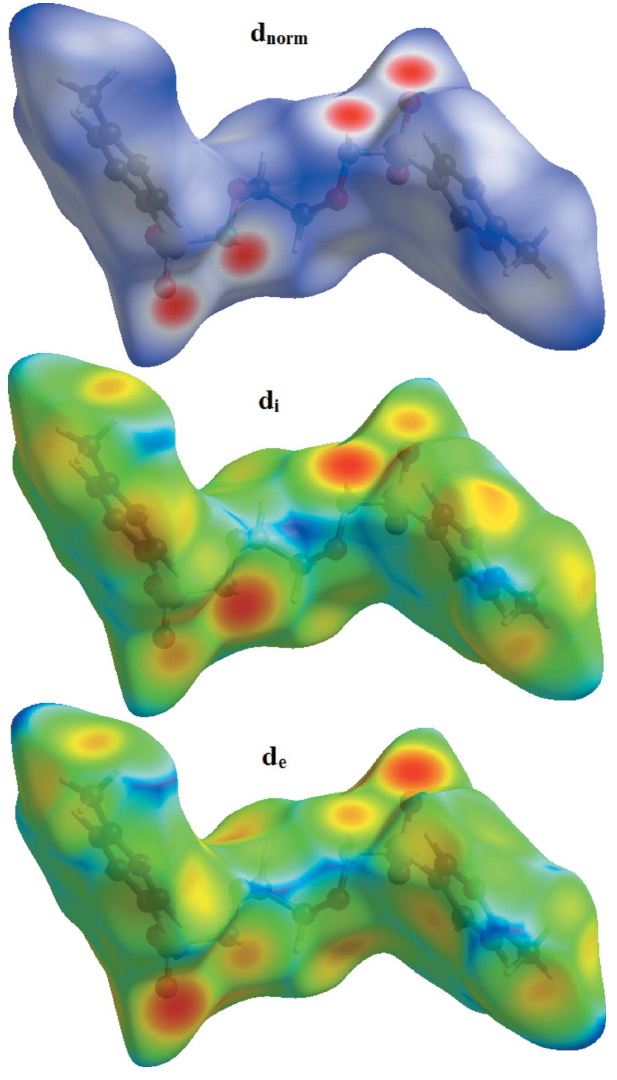
Figure 4 The Hirshfeld surface of the title compound mapped over d norm , d i and d e .